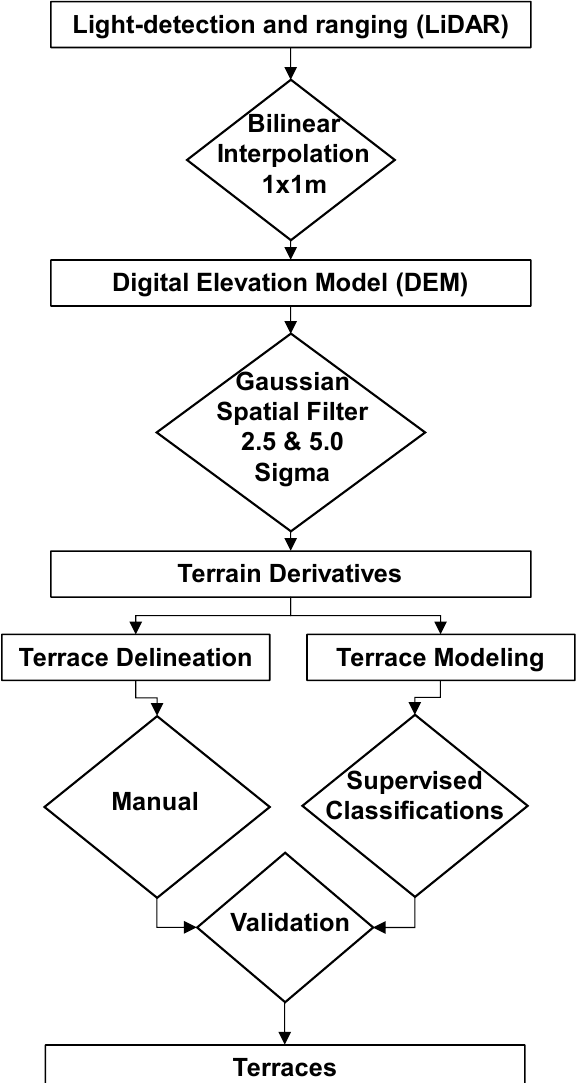
Figure 1. A schematic diagram for the analysis and production of terrace location classifications used in the paper. Table 1. The terrain derivatives calculated from the digital elevation model and used to classify the terraces.